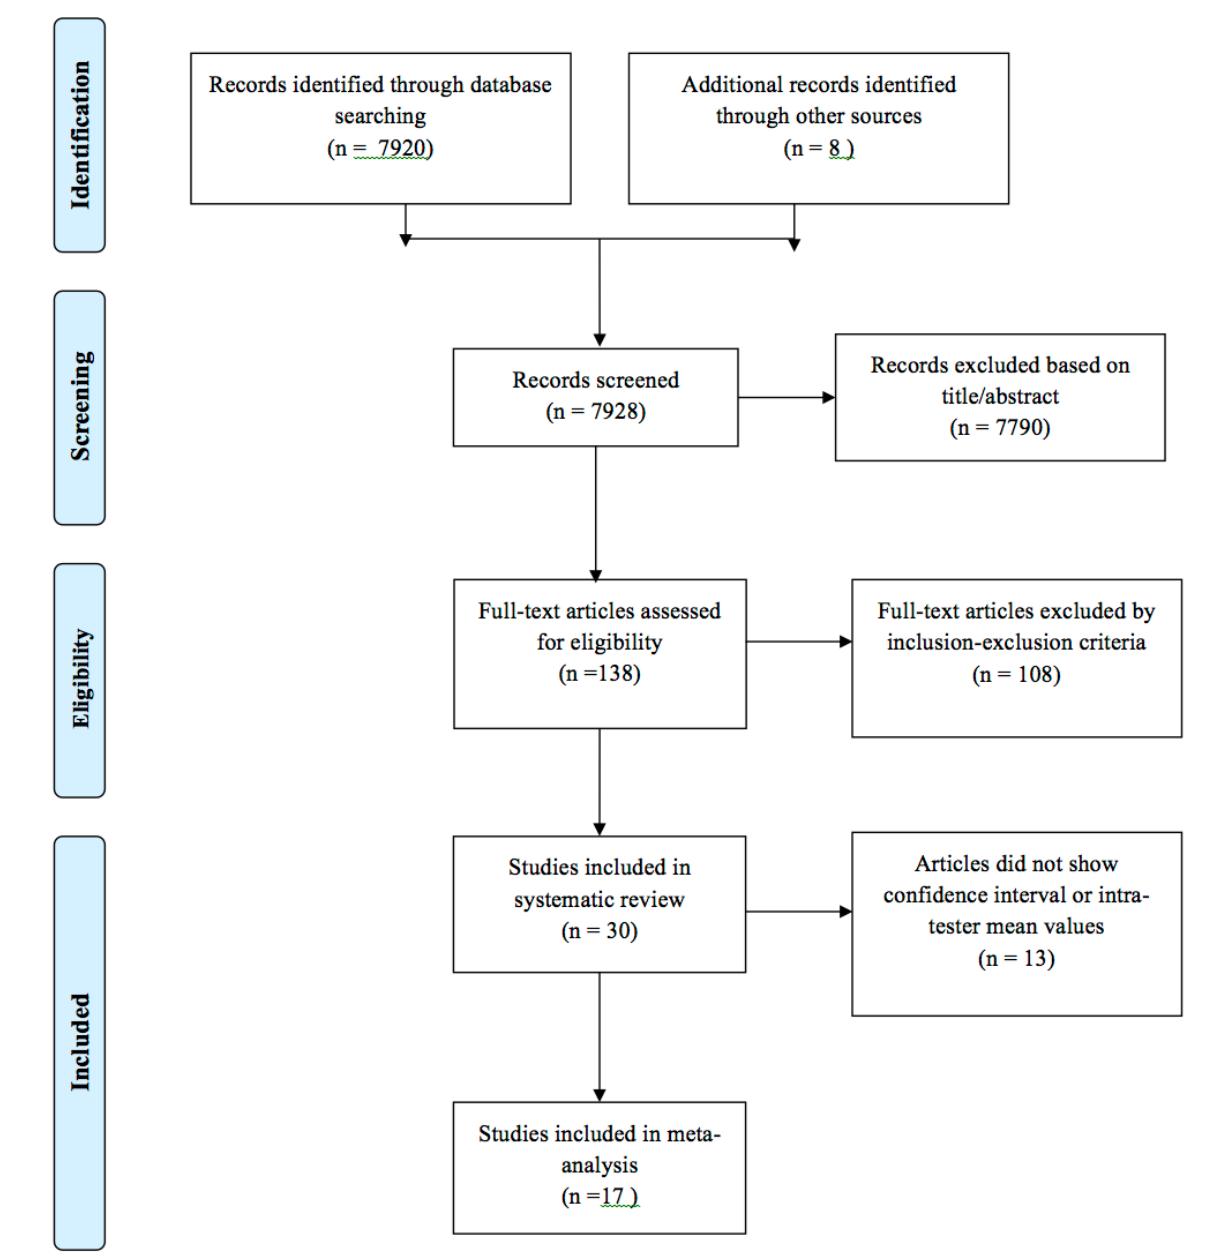
Figure 1: Flow-chart representation of selection process for manuscripts to be considered within this systematic